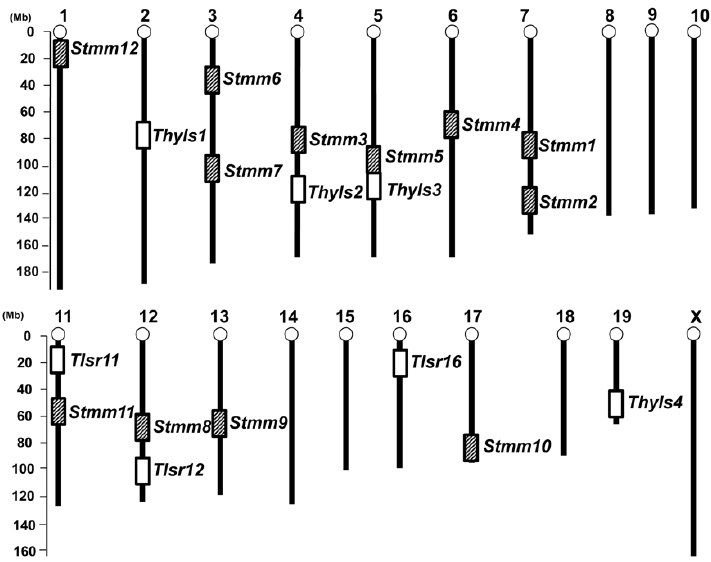
Figure 1. Tumor resistance (susceptibility) and LOH (Loss of Heterozygosity) regions identified in skin and radiation- induced tumors with MSM. Stmm ; Skin tumor modifier of MSM, Thyls ; Thymic lymphoma susceptibility, Tlsr ; Thymic lymphoma suppressor region. Shaded squares indicate Stmm loci identified in skin. White squares indicate Thyls and Tlsr loci identified in thymic lymphomas. Black bars indicate each chromosome.